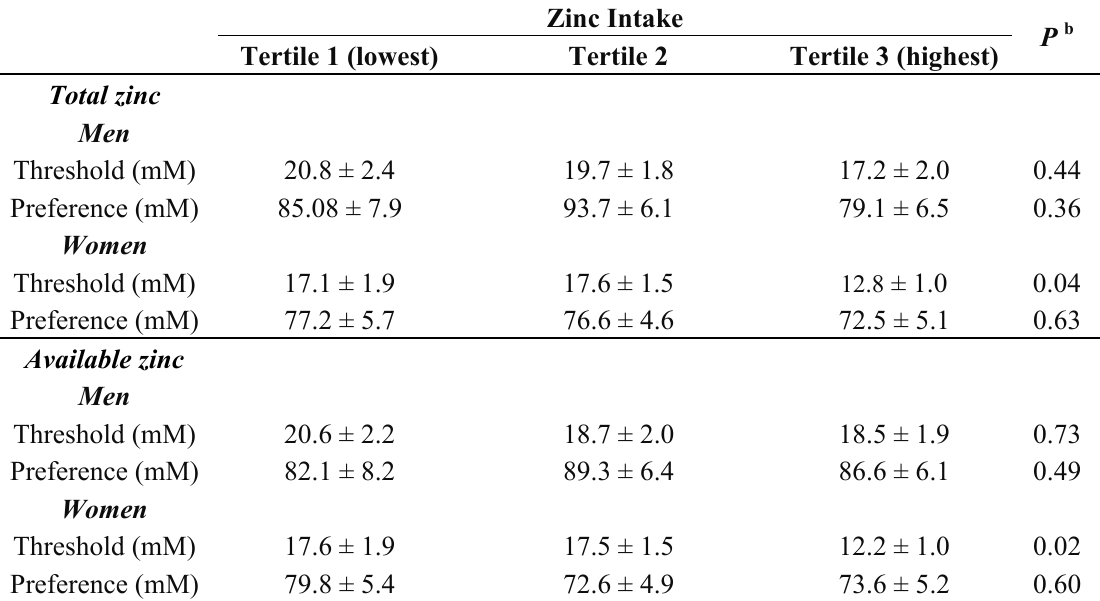
Table 3. Salty taste threshold and preference by tertiles of zinc intake in men and women a .